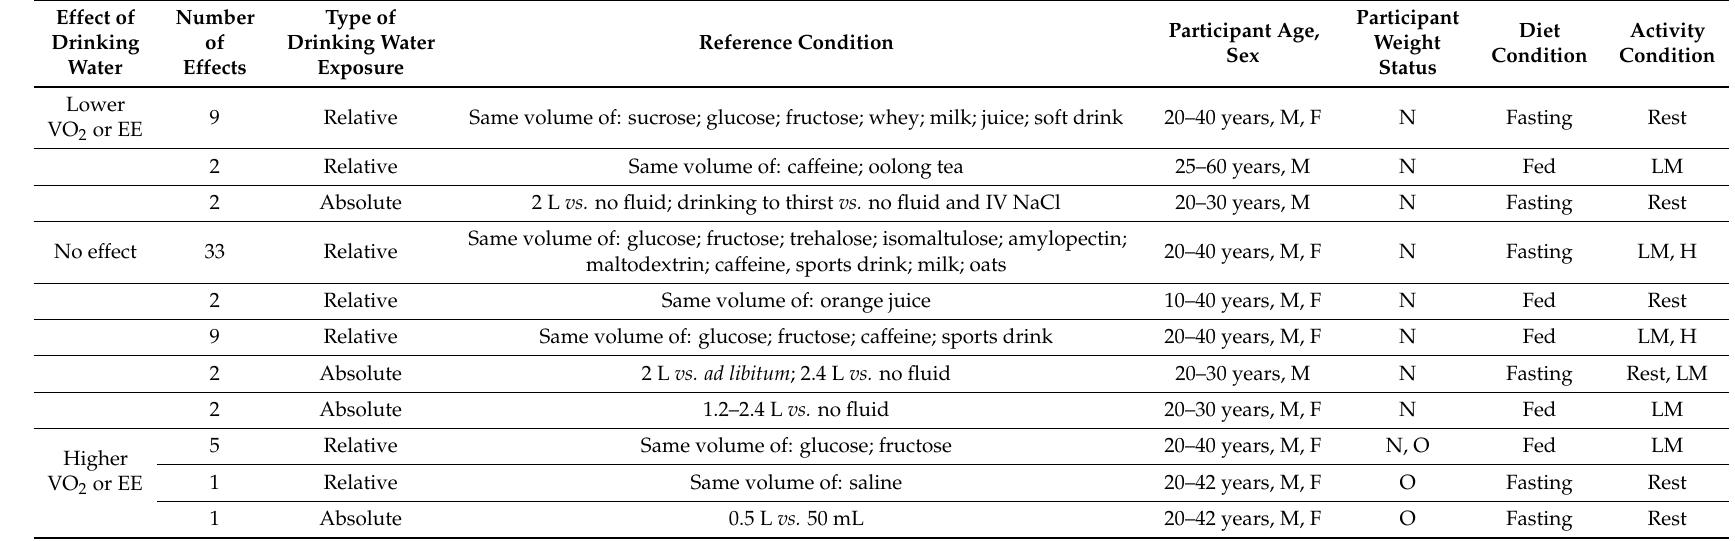
Table 3. RCT conditions associated with negative, null and positive effects of plain drinking water on oxygen consumption or energy